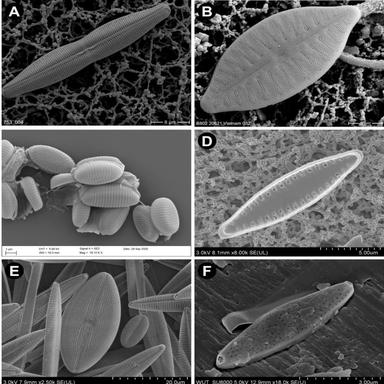
SEM images of diatoms from various habitats: (A) Craspedostauros sp., (B) Planothidium sp., (C) Psammoneis obaidii, (D) Pseudostaurosira brevistriata, (E) Mastogloia vasta Hustedt, (F) C. taylorii.